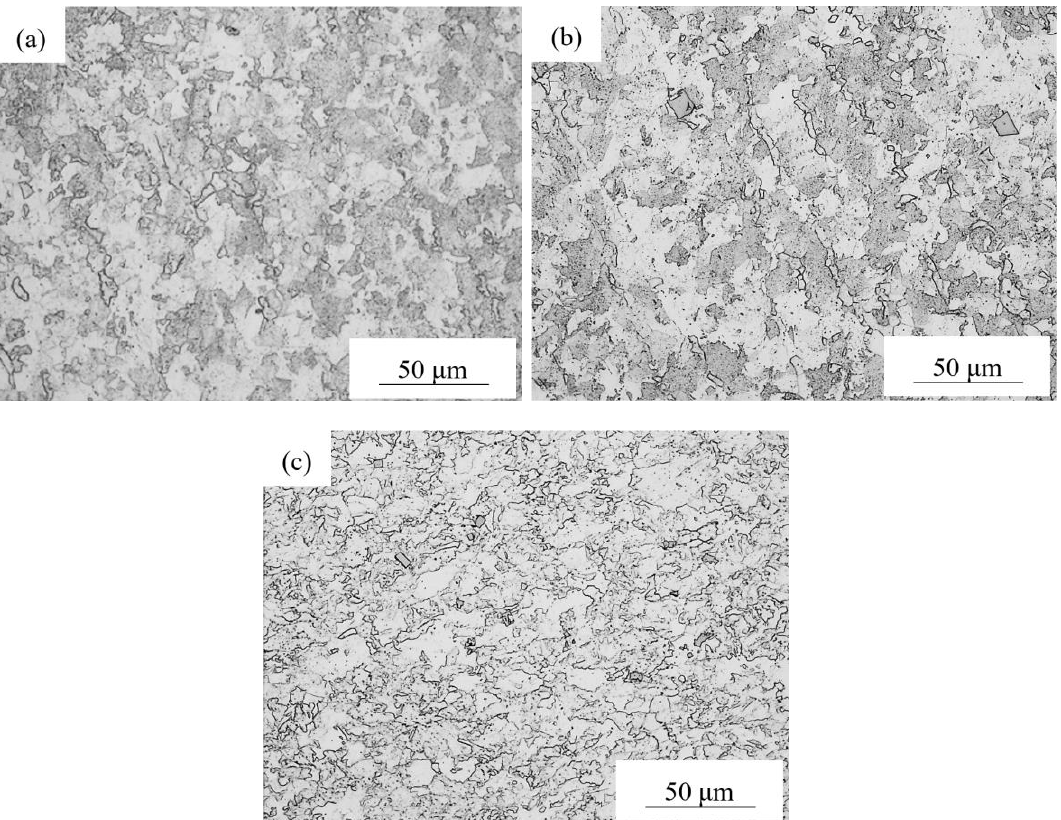
Figure 11. Optical micrographs of the low-carbon ferritic stainless steel samples with the different deformation reductions: ( a ) 0.2, ( b ) 0.5, ( c ) 0.9.